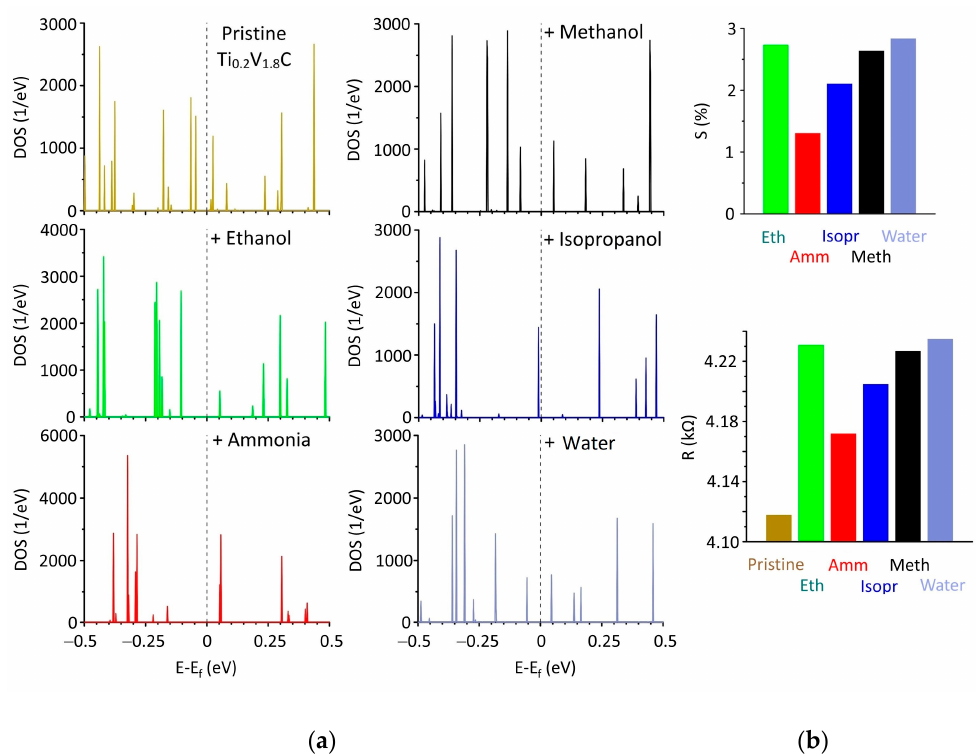
Figure 6. The DFT modeling of interaction between Ti 0.2 V 1.8 C MXene and analyte molecules under study: ( a ) DOS without smearing characterizing the supercell upon adsorption of the analytes; ( b ) dependence of the supercell resistance and its chemiresistive response upon the analyte adsorption.